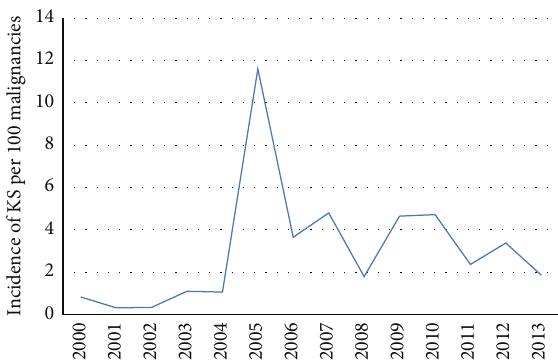
Figure 1: Trends in the incidence of KS from 2000 to 2013.